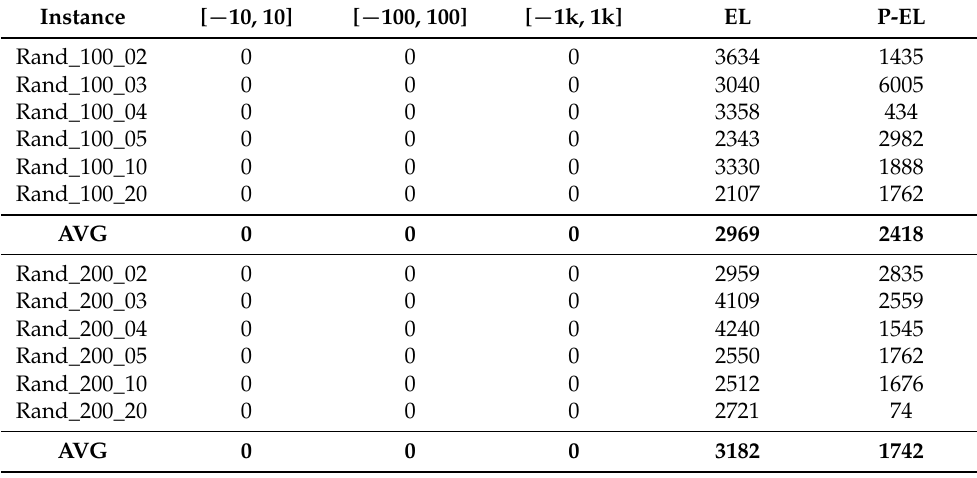
Table 6. Objective function value for the random